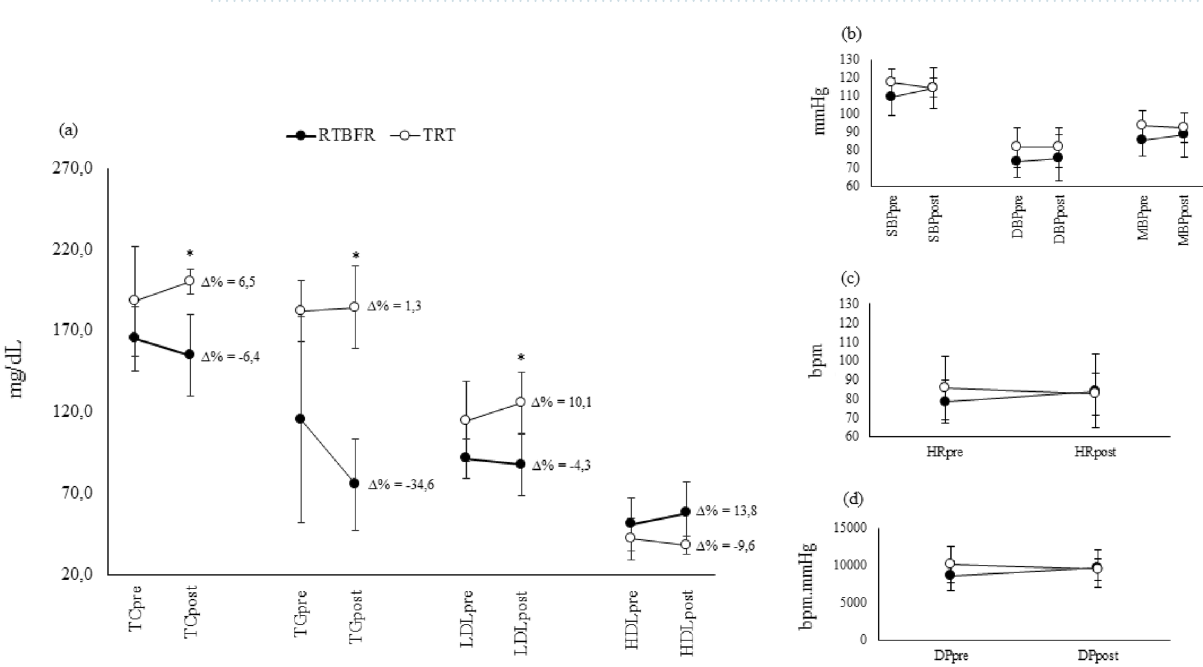
Figure 5. Chronic effects between and within groups (pre vs post-training) for lipids ( a ), blood pressure ( b ), heart rate ( c ), and double product ( d ). *p < 0.05: Statistically significant difference between groups (general linear models-GLM with SIDAK post hoc test) cardiovascular variables at rest. RTBFR: resistance training with blood flow restriction; TRT: traditional resistance training; SBP: systolic blood pressure; DBP: diastolic blood pressure; MBP: mean blood pressure; HR: heart rate; DP: double product; TC: total cholesterol; HDL: high- density lipoprotein cholesterol; LDL: low-density lipoprotein cholesterol; TG: